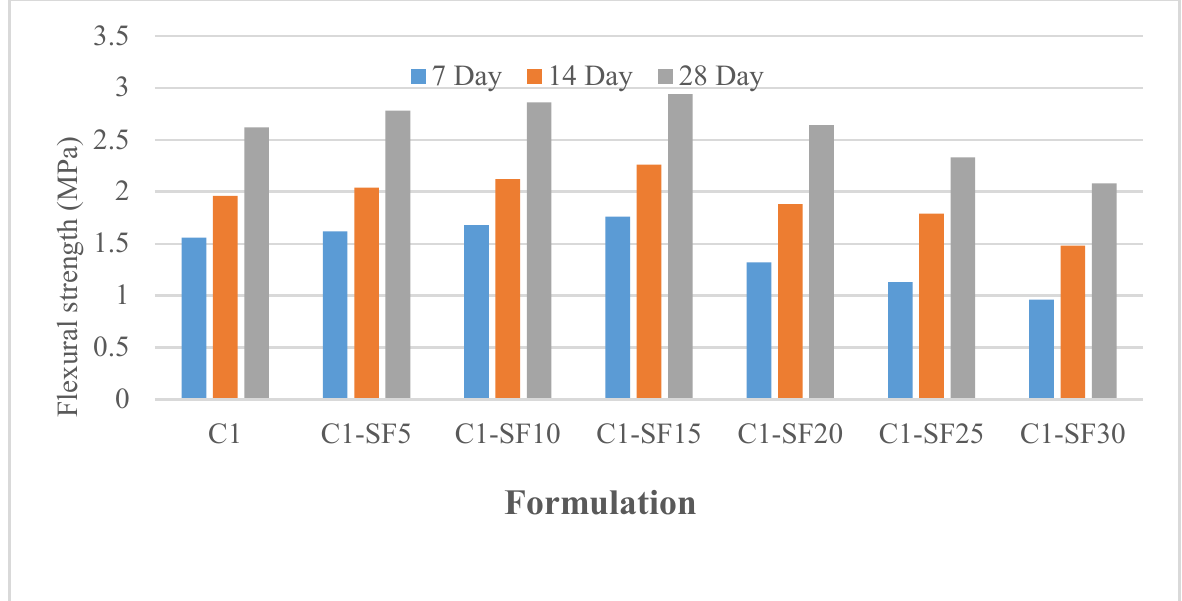
Figure 5. Flexural strength of concrete human hair fiber with silica fume.